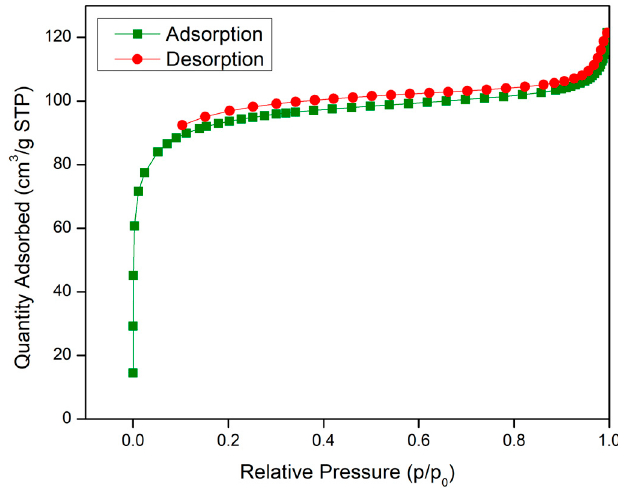
Molecules 2023 , 28 , x FOR PEER REVIEW Figure 8. Nitrogen adsorption–desorption isotherms curves for UiO − 66. Figure 8. Nitrogen adsorption–desorption isotherms curves for UiO-66.